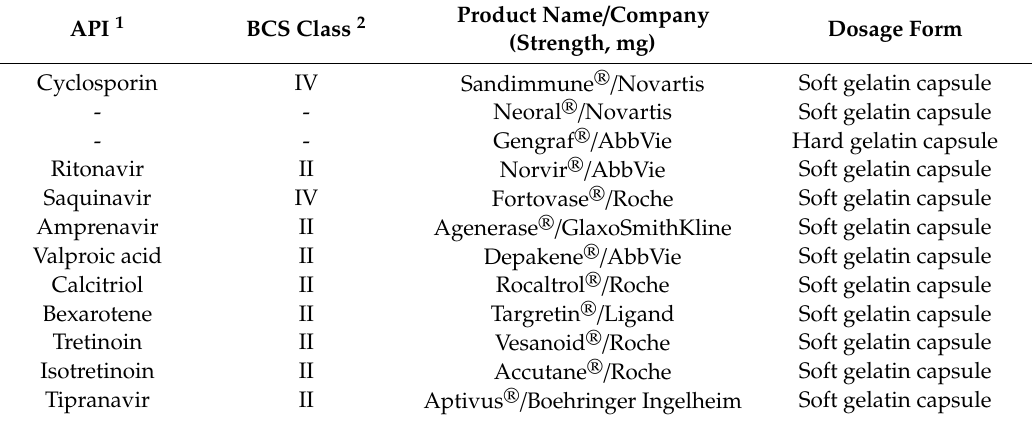
Table 1. Commercially marketed medicinal products of self-emulsifying drug delivery systems (SEDDS)